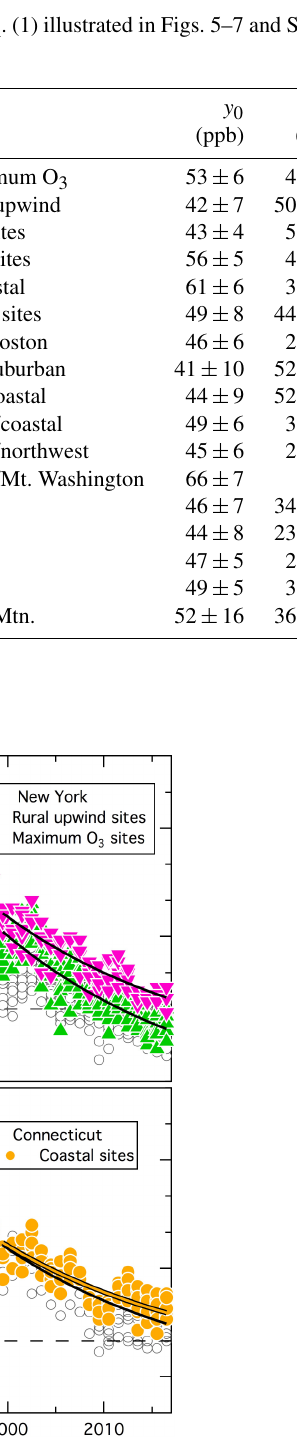
Figure 6. Time series of all ODVs (grey symbols) reported from all monitoring sites in Massachusetts and Maine. The four sets of colored symbols indicate the results from groups of sites that are discussed in detail. The curves are fits of Eq. (1) to respective col- ored